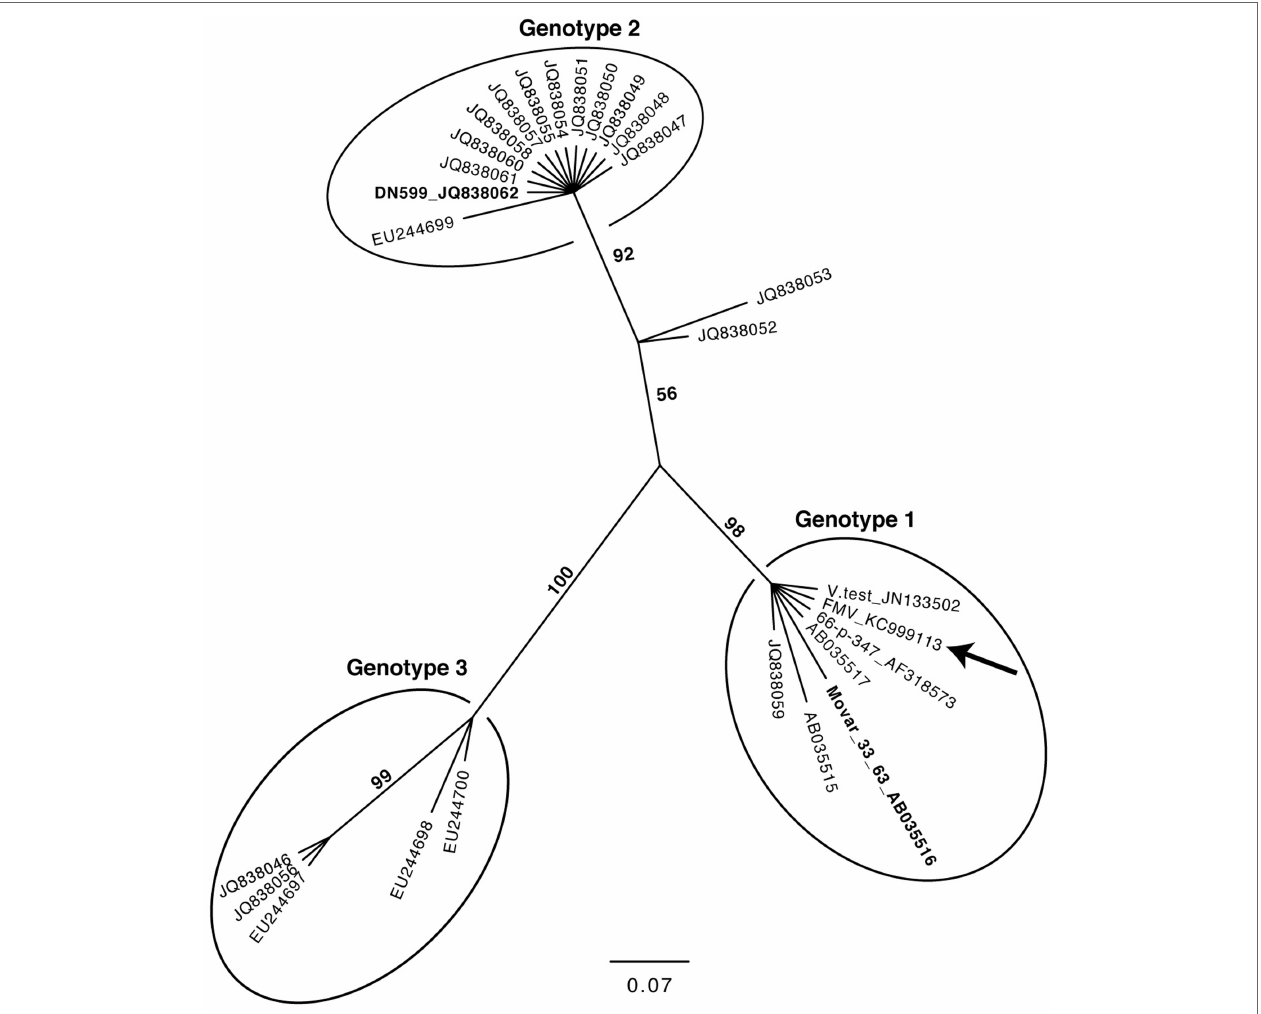
FigUre 4 | Molecular phylogeny of the Thymidine kinase (TK) gene from various bovine herpesvirus 4 strains. The phylogeny of TK gene sequences (212 nucleotides in length) from 27 bovine gammaherpesvirus 4 (BoHV-4) strains (Table S2 in Supplementary Material) was determined using MrBayes programs. Numbers on branches correspond to posterior probabilities. Branch length is proportional to the number of nucleotides substitutions. The tree is unrooted. The arrow points to the BoHV-4-FMV strain. The reference strains Movar_33_63 and DN599 are in